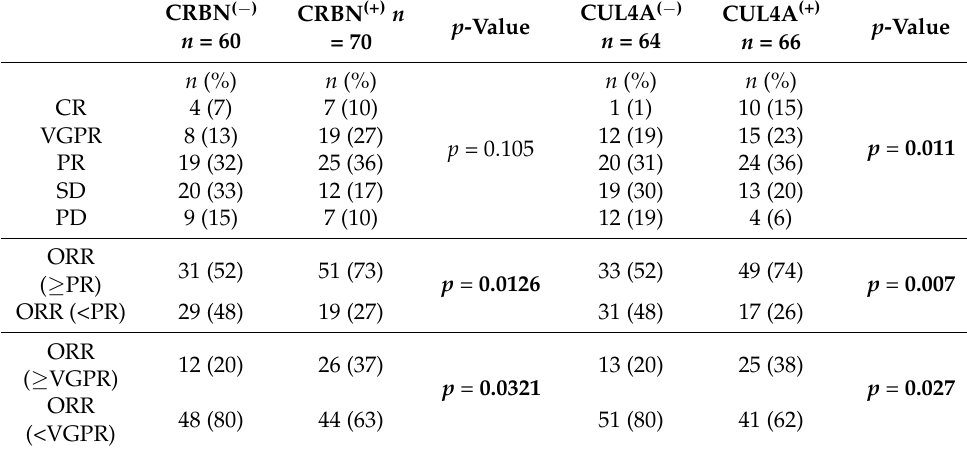
Table 2. Quality of IMiD-based treatment response stratified by CRBN and CUL4A expression. Abbreviations: CR—complete response; VGPR—very good partial response; PR—partial